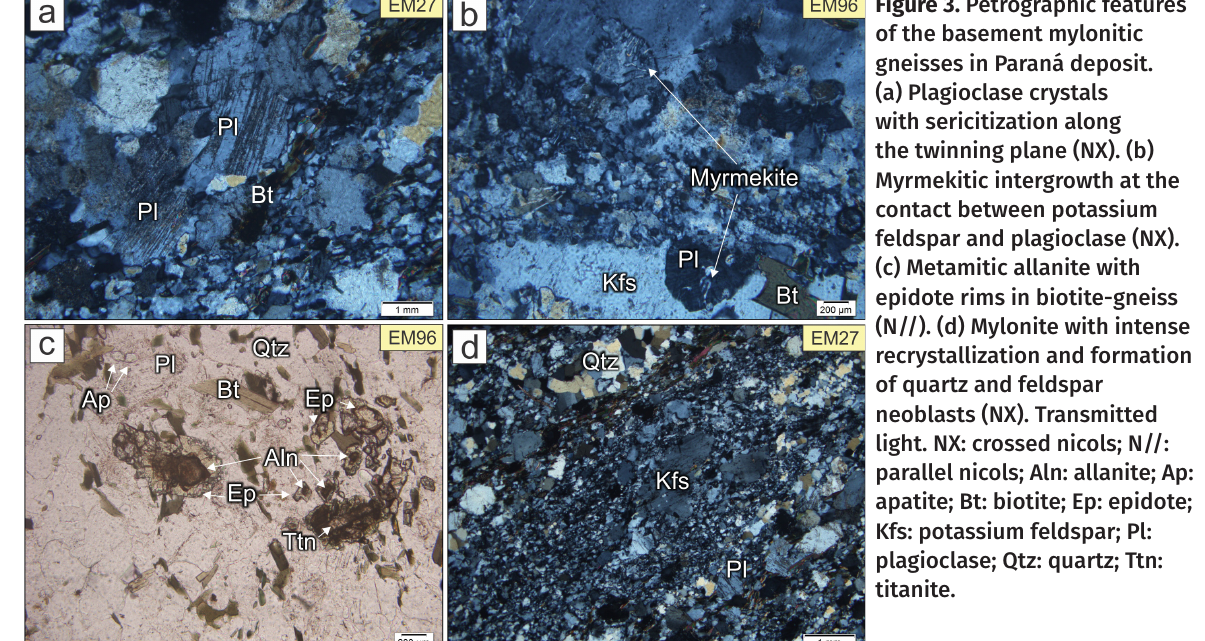
Figure 3. Petrographic features of the basement mylonitic gneisses in Paraná